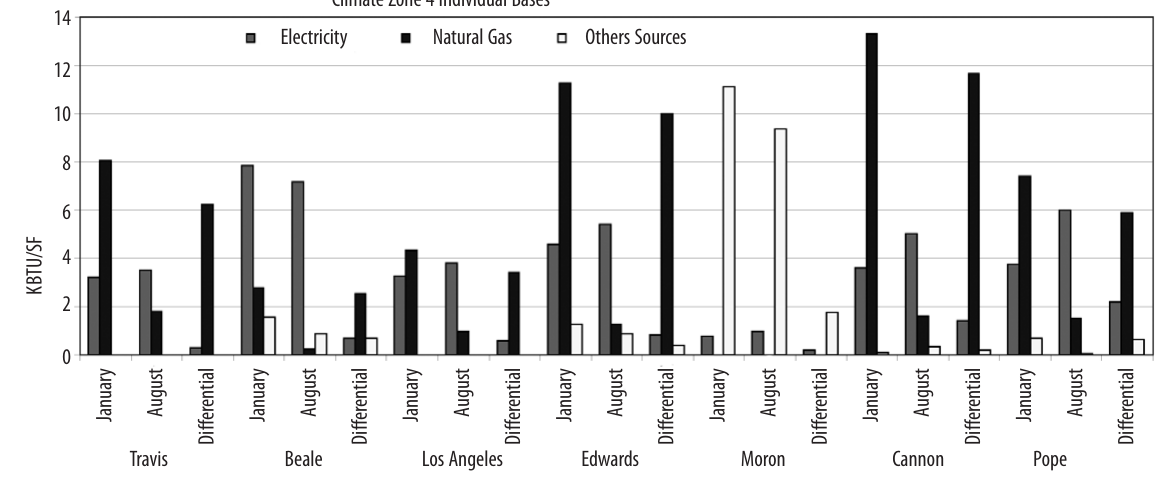
Fig. 6. Energy source consumption in climate zone 4